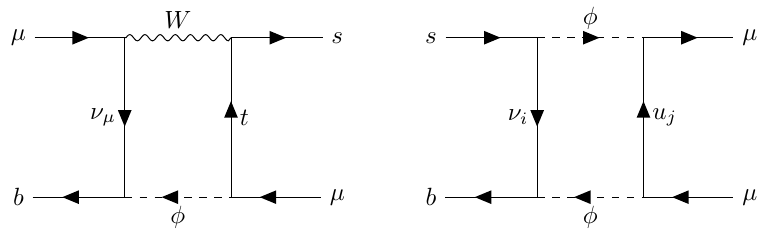
Figure 3. The box diagrams contributing to C (cid:30)